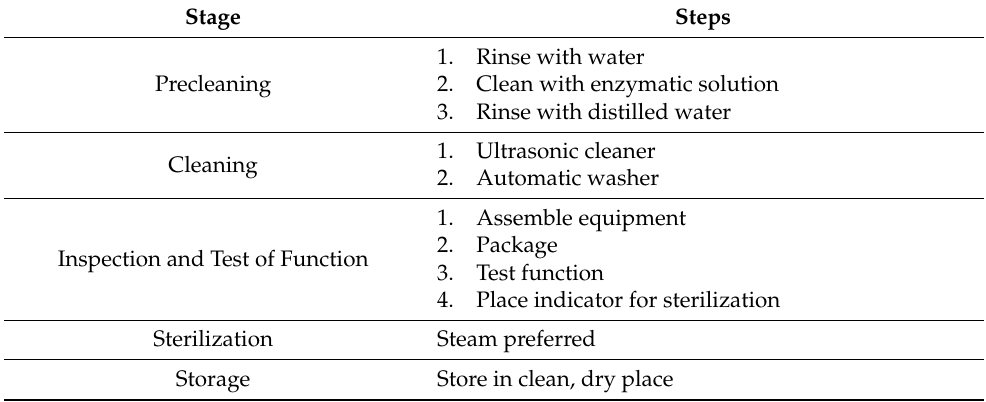
Table 2. Example of sterile reprocessing at a high-level hospital in the United